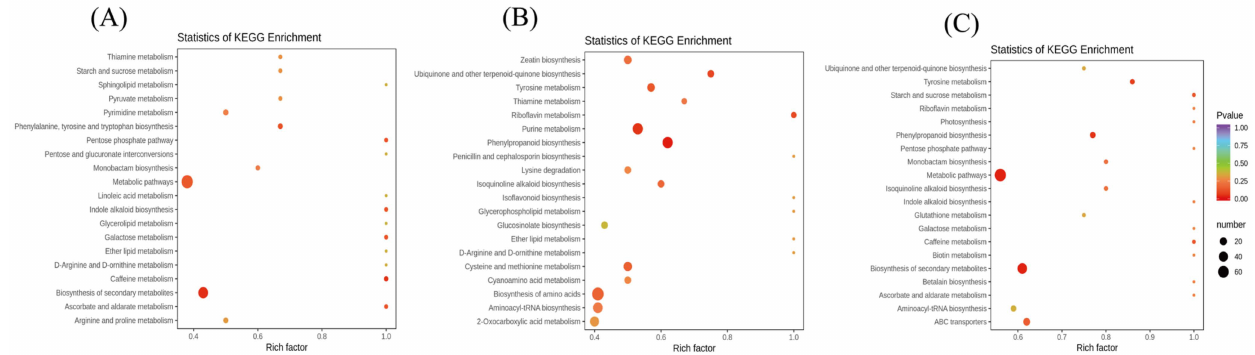
Figure 4. KEGG enrichment analysis of differentially accumulating metabolites. ( A ) Differentially accumulating metabolites between Rr5-30 and Rr5-60. ( B ) Differentially accumulating metabolites between Rr5-60 and Rr5-90. ( C ) Differentially accumulating metabolites between Rr5-30 and Rr5-90. Each circle in the plot represents the number of associated metabolites and is the position according to its abundance factor. The p -values are indicated by